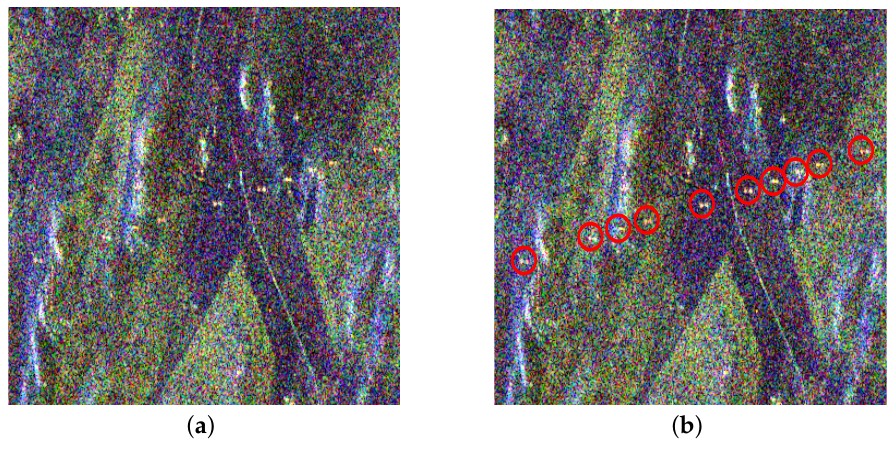
Figure 7. Pauli color coded image of Inner Mongolia. ( a ) original PolSAR image; and ( b ) marked image.